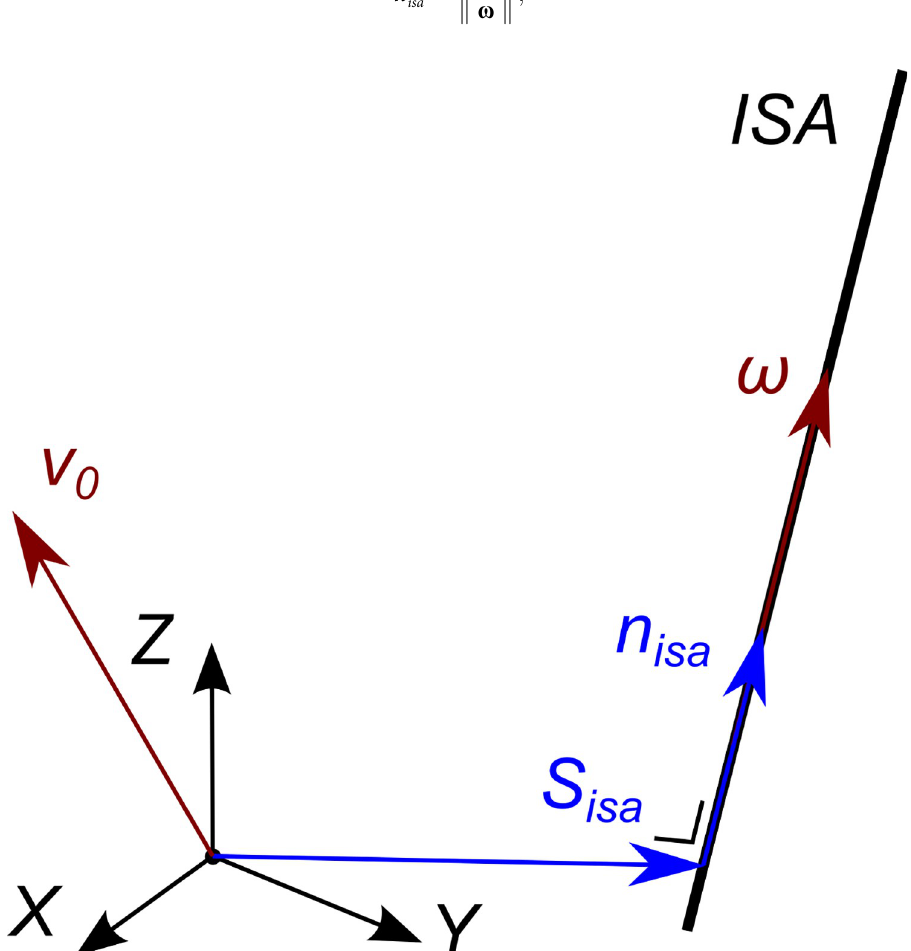
Fig 1. Definition of the ISA with respect to the world coordinate